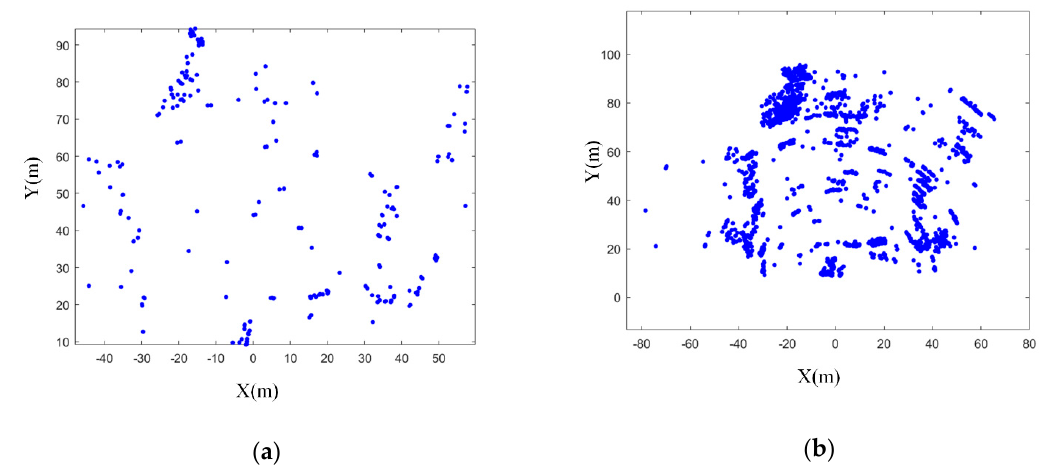
Figure 3. Point cloud of radar. ( a ) Single frame scanning point cloud of radar; ( b ) “Multi-scan” with N = 20.